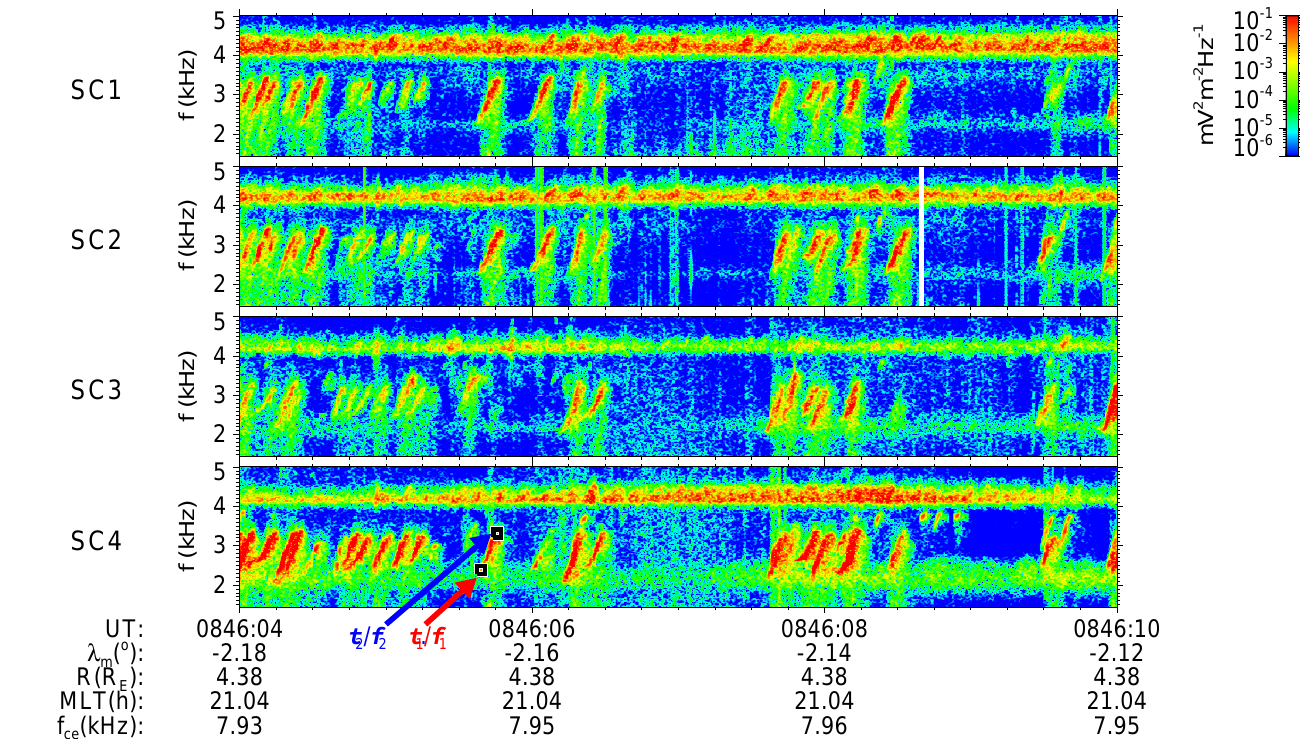
Fig. 1. Example frequency-time spectrogram of the power-spectral density of electric field fluctuations measured by the WBD instrument on board the four Cluster spacecraft (SC1-SC4) on 18 April 2002. Magnetic latitude, radial distance, magnetic local time, and the local electron cyclotron frequency from averaged data of the FGM instrument (Balogh et al., 2001) are given on the bottom for Cluster 4. Arrows illustrate an example of the starting point [ t 1 ,f 1 ] (red) and the final point [ t 2 ,f 2 ] (blue) of a single chorus wave